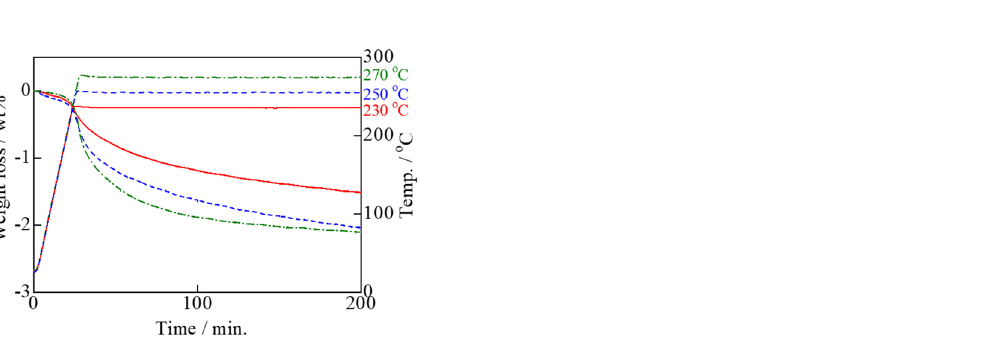
Figure 14. Isothermal TG analysis of carbon black (2 wt%) mixed with the Tl 2 O 3 ‒ 95 wt%Bi 2 O 3 composite catalyst at constant temperatures of 230, 250, and 270 °C for 3 h.